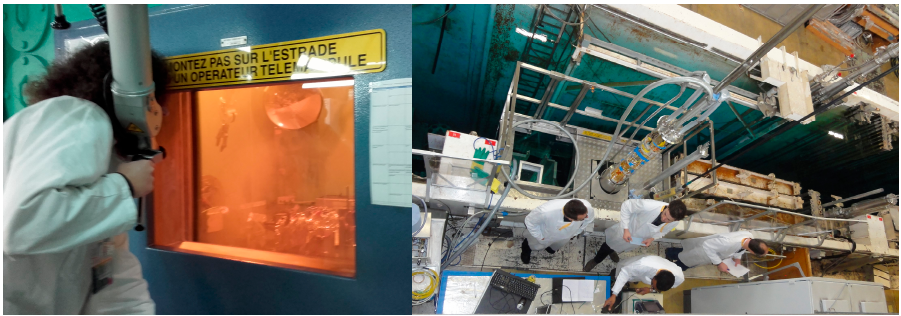
Figure 11. Picture of IRMA ( left ) and BRIGITTE ( right ) facilities used for irradiation of optical fibre sensors.